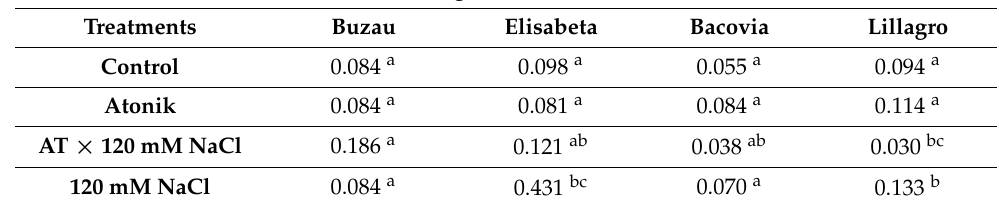
Table 1. Tomato leaves proline content under the action of salt stress and Atonik biostimulant. Different letters in the same column mean significant differences between treatments, according to the Tukey test ( p ˂ 0.05) .